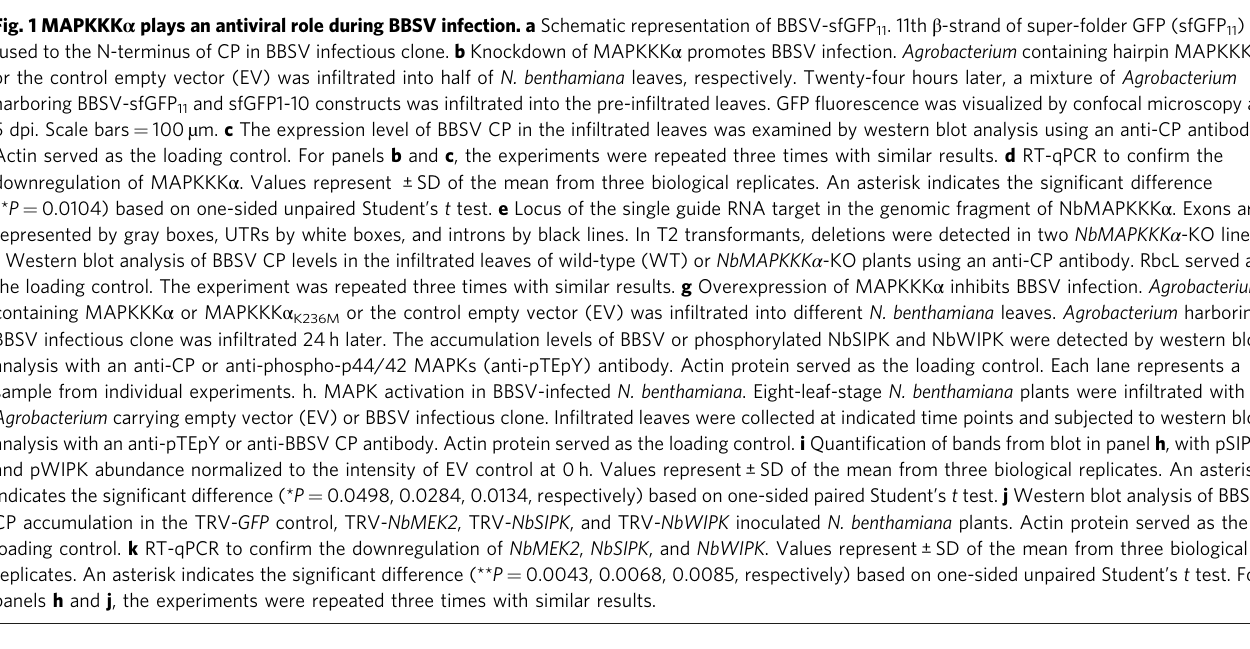
MAPKKK α K236M (Supplementary Fig. 2). The expression of MAPKKK α and MAPKKK α K236M was con fi rmed by western blot (Fig. 1g, middle panel). These results suggest that MAPKKK α